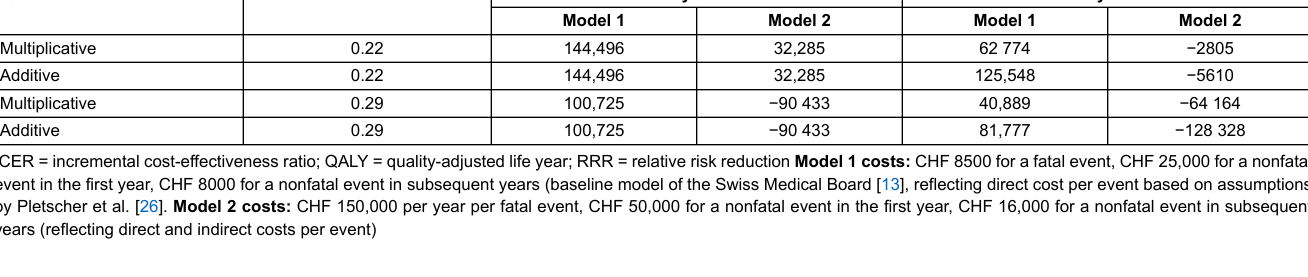
Table 7: Cost effects comparing a “treat them all” strategy with a “treat 3rd TPA tertile only” strategy in the Swiss population (age 30–65), stratified further for avoidable costs per fatal case of either CHF 1.5 million in 10 years or once CHF 8500 (treatment costs according to the Swiss Medical Board).